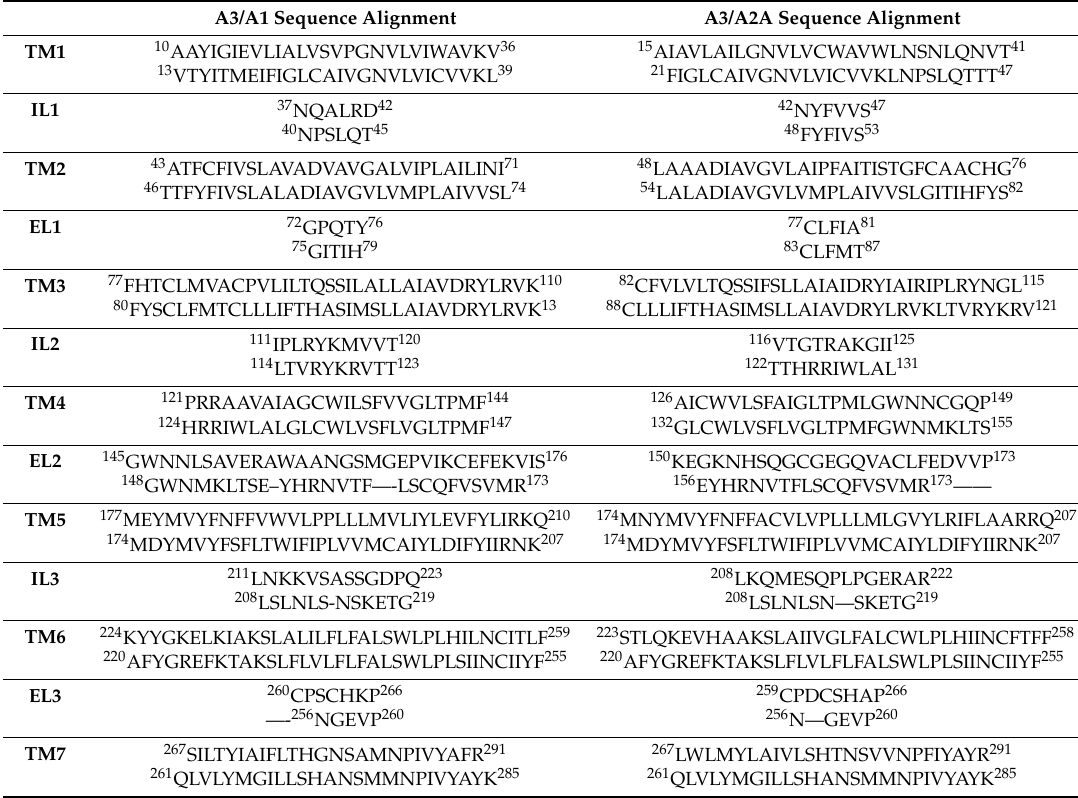
Table 1. Sequence alignment of the hA3 AR canonical isoform primary sequence (second row) on the PDB crystallographic structures 5UEN (hA 1 AR) and 3PWH (hA 2A AR), basing on respective structural